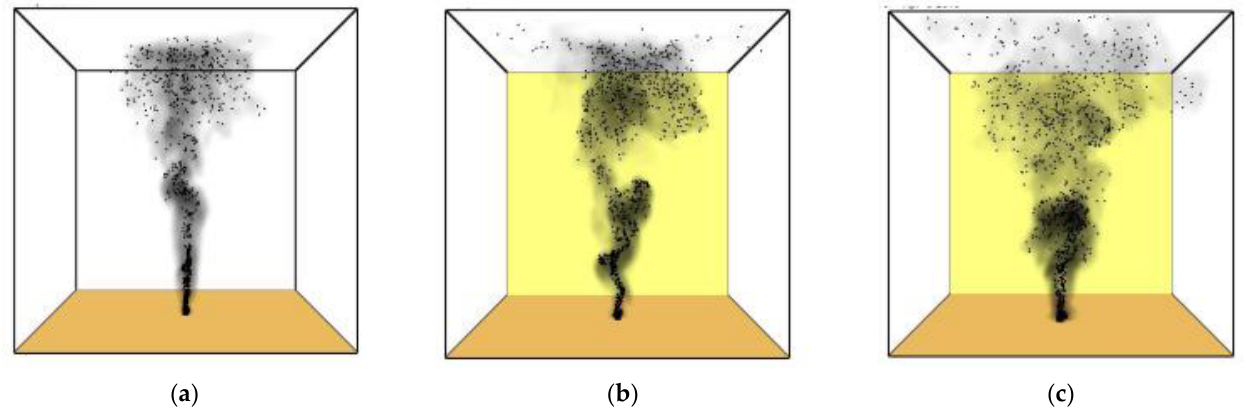
Figure 7. Smoke distribution in cross-wind direction for different wind speed [83] (( a ) v = 0, ( b ) v = 1 (m/s), ( c ) v = 2.5(m/s)).